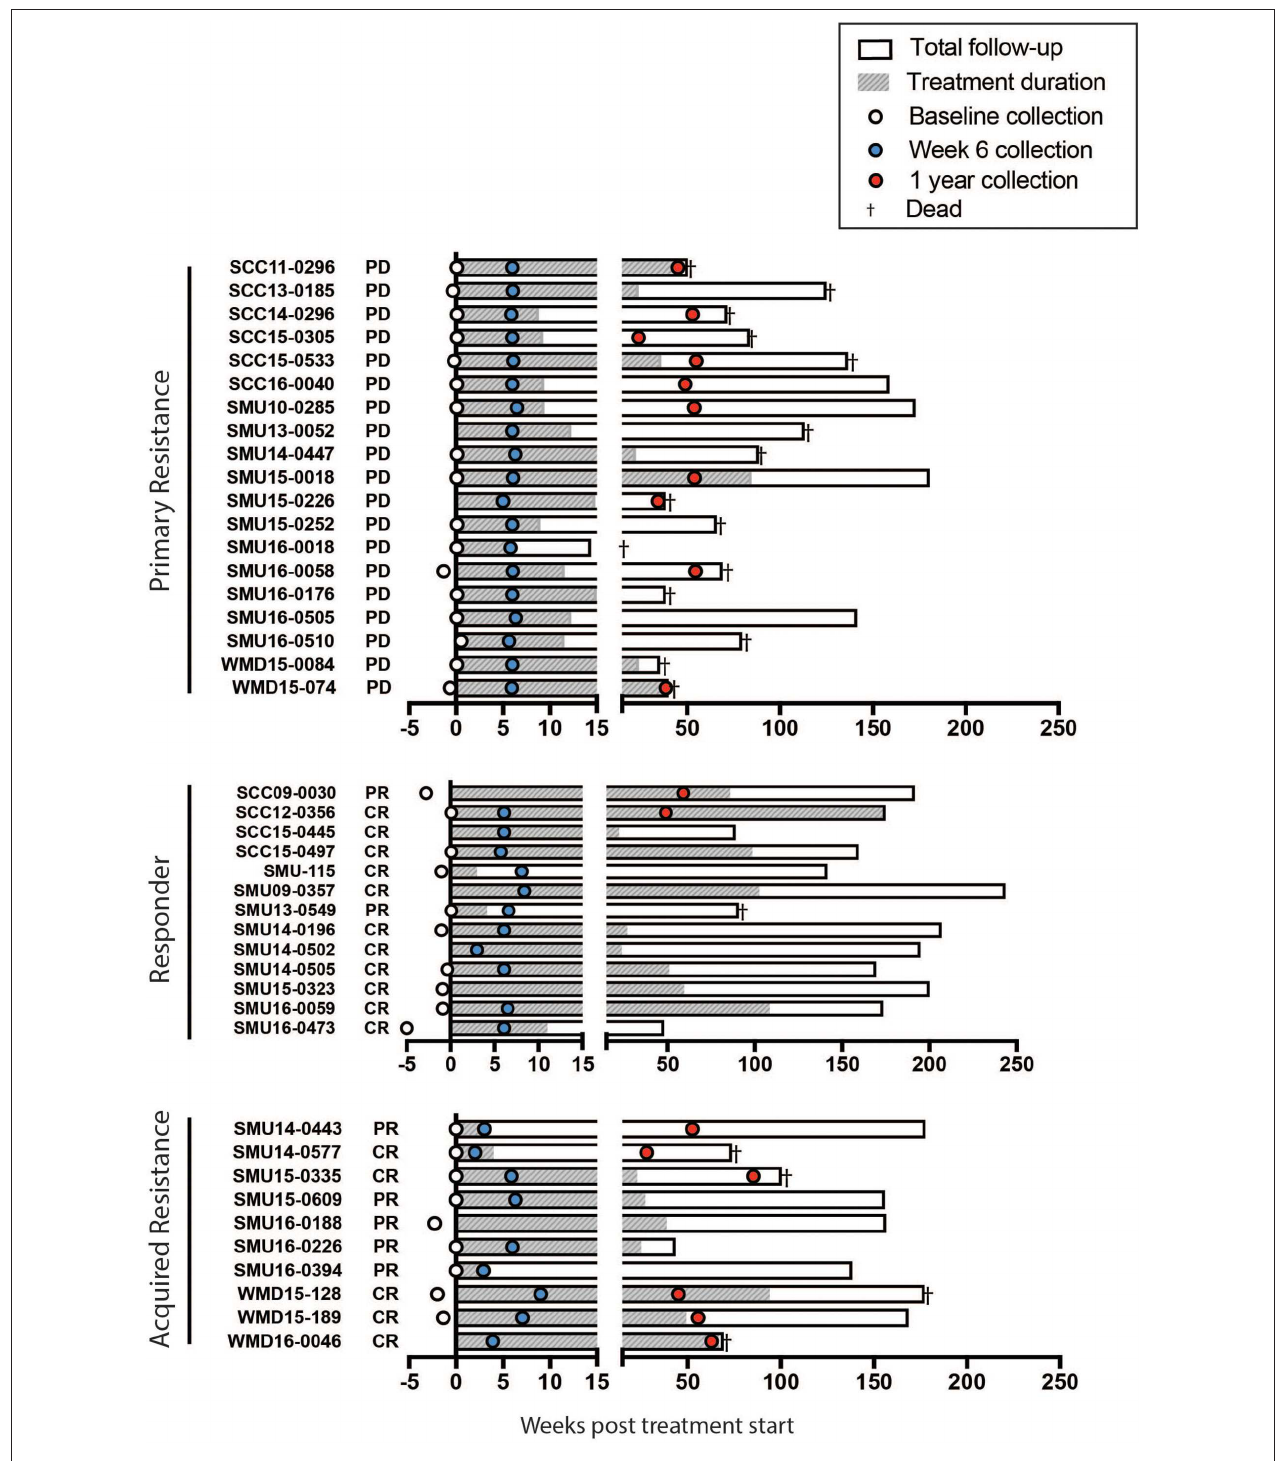
FIGURE 2 | Swimmers plot illustrates treatment duration of patients treated with anti-PD-1 (filled bars), within the study follow up period (open bars) for primary resistance, responders, and acquired resistance groups. Death is illustrated with a cross. Blood samples were obtained at baseline (open circles, range 0-5 weeks before the start of therapy), week 6 (blue filled circles, range 2-9 weeks) and 1 year (red filled circles, range 35-85 weeks) post treatment. CR, complete response; PR, partial response; PD, progressive disease, as assessed using RECIST.